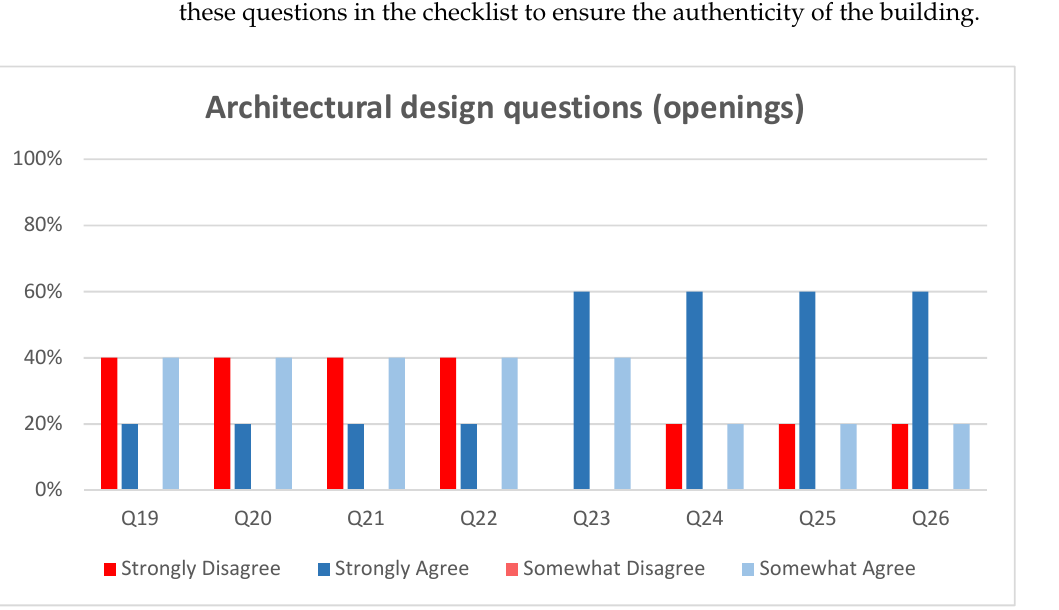
Figure 9. Results of the questions on openings.